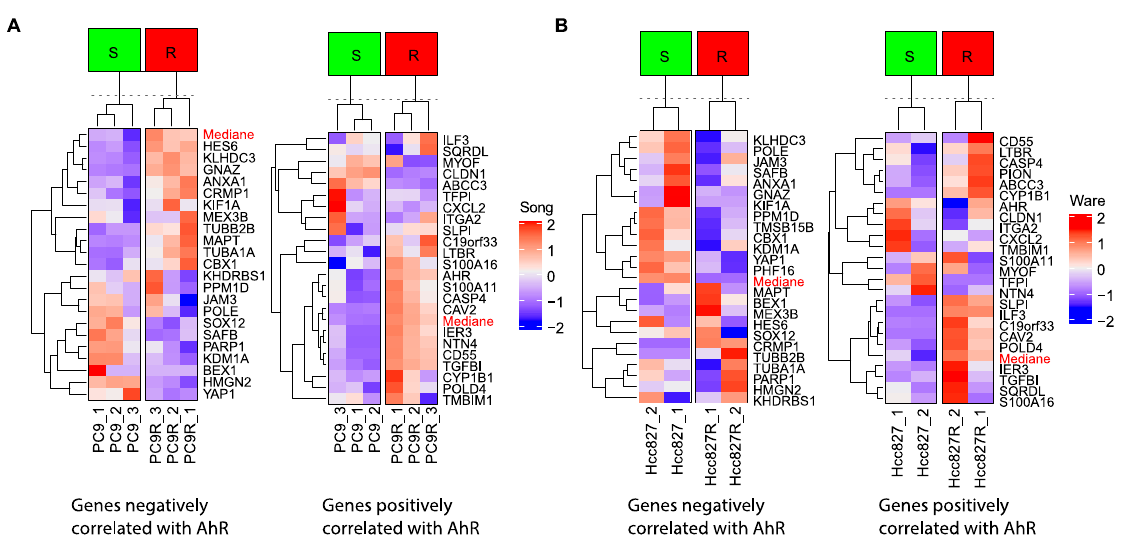
Figure 6. AhR signatures in tyrosine kinase inhibitor (TKi)-resistant (gefitinib) lung-cancer cell lines. ( A , B ) Expression heatmap showing the expression of genes that correlate the most highly (positively or negatively) with AhR mRNA levels (Figure 2A) in lung-cancer cell lines sensitive or resistant to a TKi (Gefitinib) from the data sets of Song et al. [117] ( A ) and Ware et al. [118] ( B ). Genes and clusters with similar expression profiles across the cohort are placed close to each other in the grid.